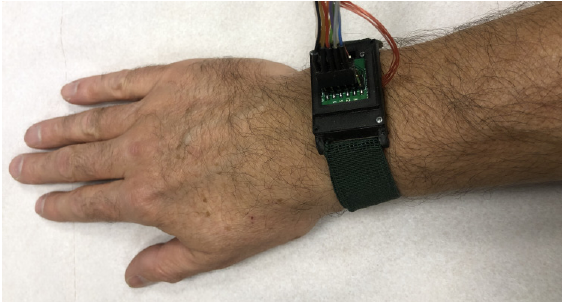
Figure 2. Picture of training data-capture setup. The hardware is described in [16].